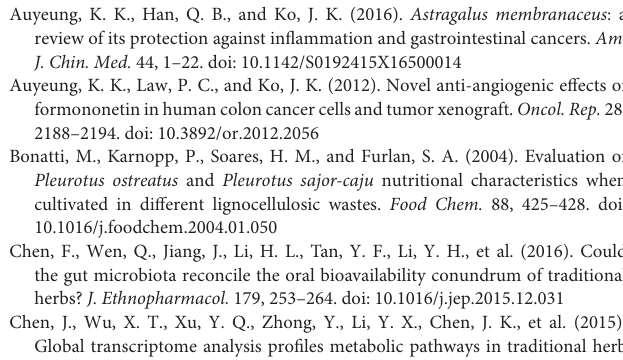
Supplementary Figure 1 | Representative UPLC-MS typical base peak intensity chromatograms of QC samples. Supplementary Figure 2 | The standard curve of astragaloside